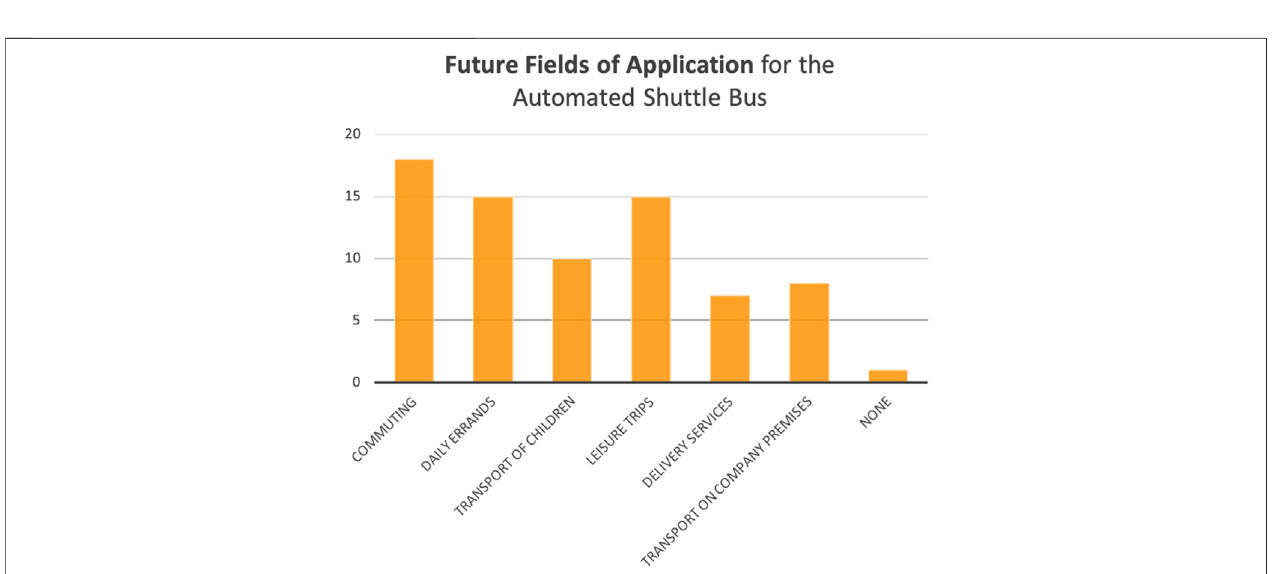
FIGURE 4 | Study 1: Responses regarding future fi elds of application for the automated shuttle bus.